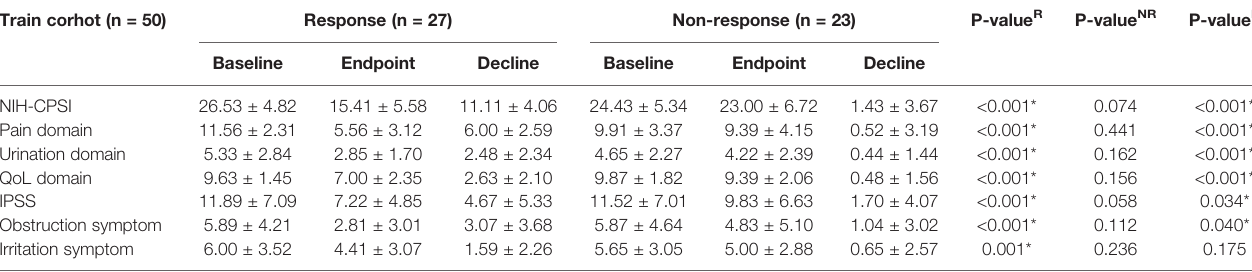
TABLE 2 | Scores of NIH-CPSI, IPSS, and their subgroup in training cohort. Train corhot (n =